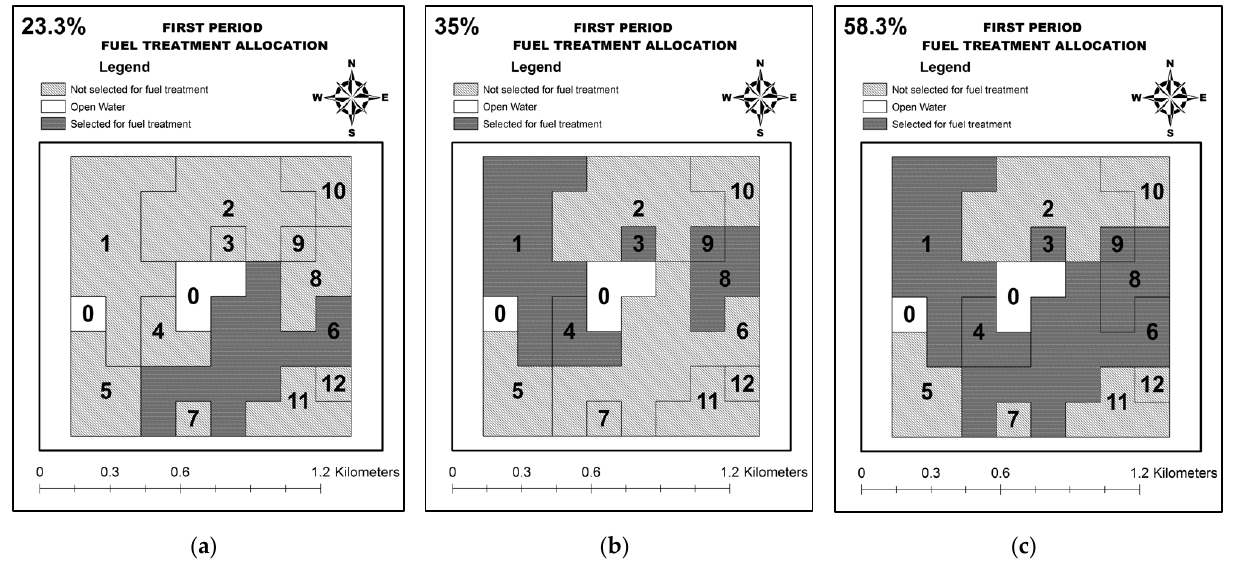
Figure 12. Some alternatives FT1s under high FPV assumption: ( a ) smaller area treated; ( b ) medium area treated; ( c ) larger area treated.